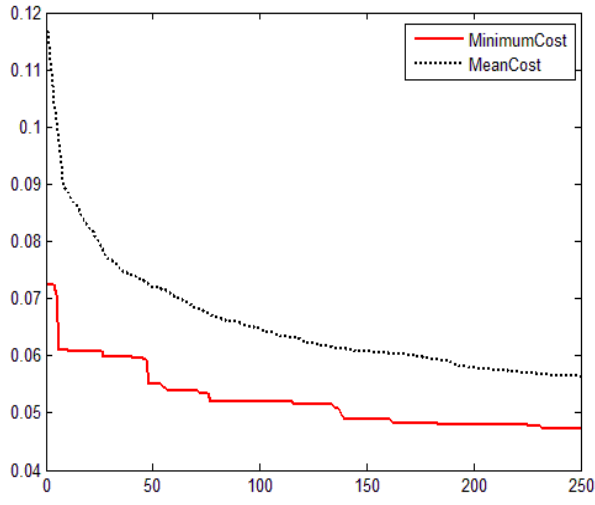
Figure 5. Graph cost for 250 iterations in the 250GEN_5IN model. Table 6. Applied GA, ICA, and PSO parameters.